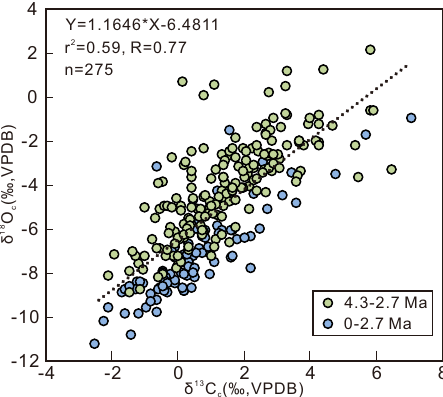
Fig. 2 A comparison of oxygen and carbon isotope data from the Kunlun Pass section. The positive correlation ( R > 0.7) between the parameters is typical of a closed lacustrine depositional environment for this set of strata 19